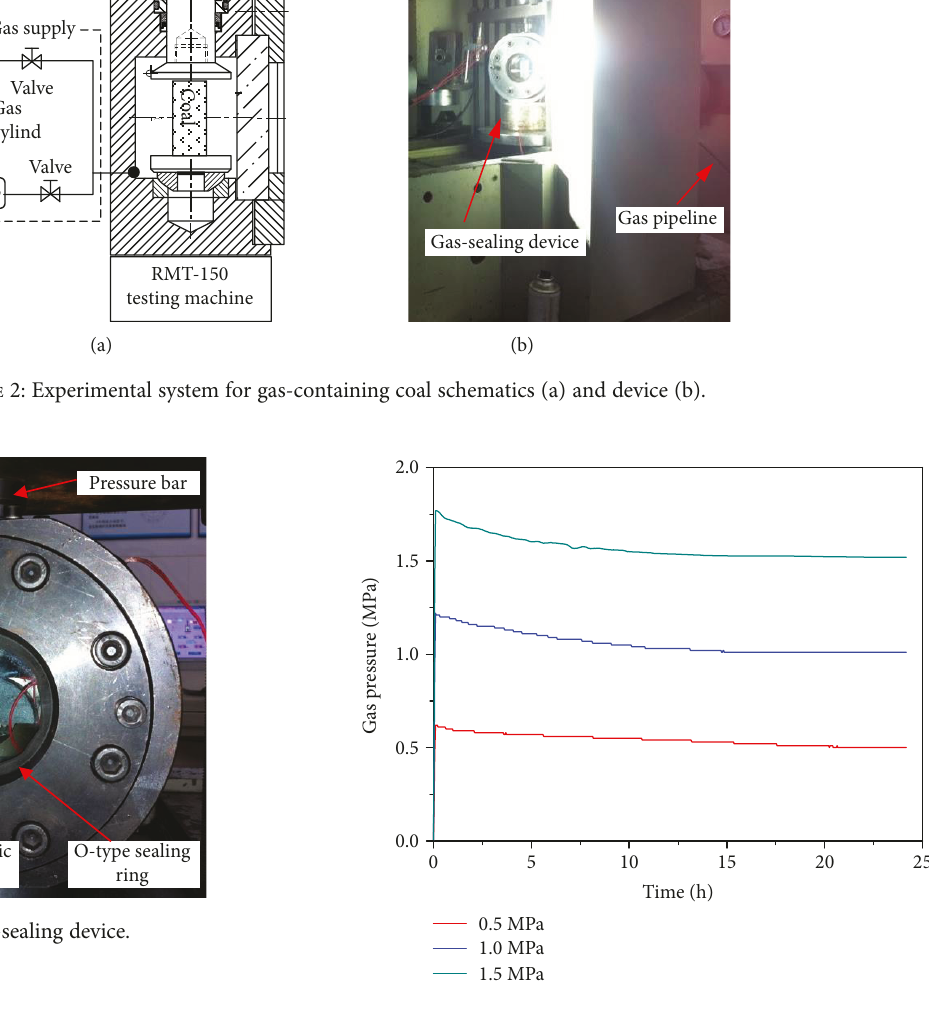
Figure 4: Gas pressure time histories before